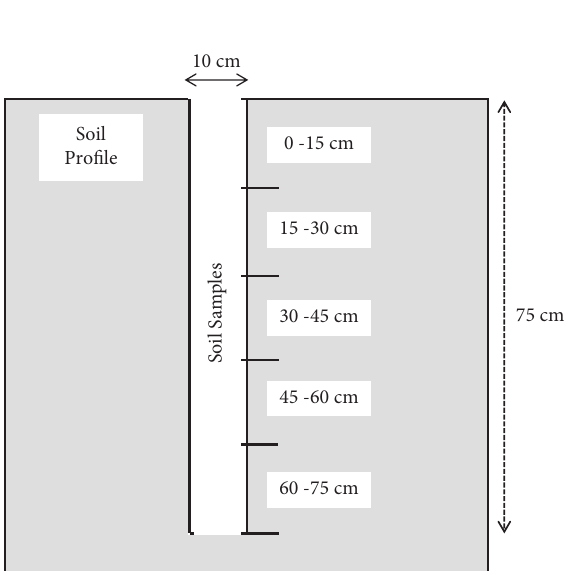
Figure 3: Depth-wise soil sampling with 15cm